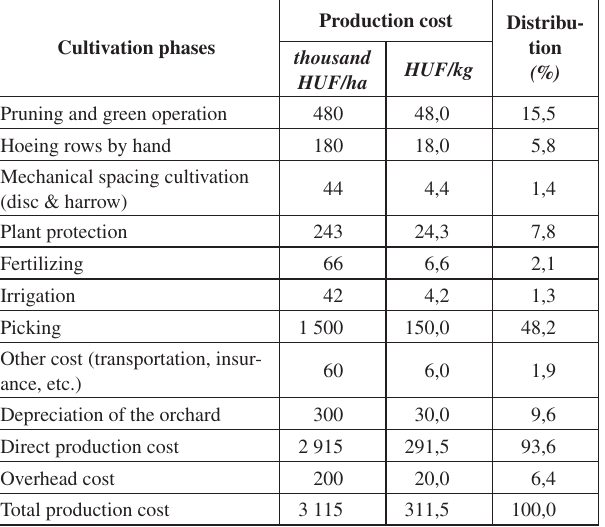
Table 1: The Production Cost of a Raspberry Orchard Cultivated on a Good Standard Relating to Cultivation Phases in a Good Year Regarding a Yield Level of 10 Tons per One Hectare